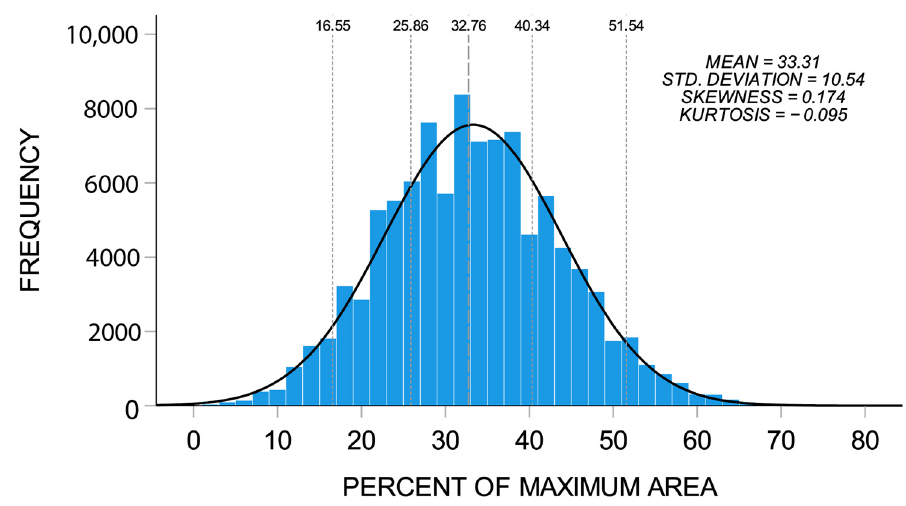
Figure 3. Distribution of TDT 25 PMA (Percent of Maximum Area) scores obtained from simulation study. Values for the 5th, 25th, 50th, 75th, and 95th percentiles are marked by the broken grey vertical grid lines. Table 2. Principal statistics for simulations of area scores of the TDT25 obtained from a biased insensate responder operating in seven states of